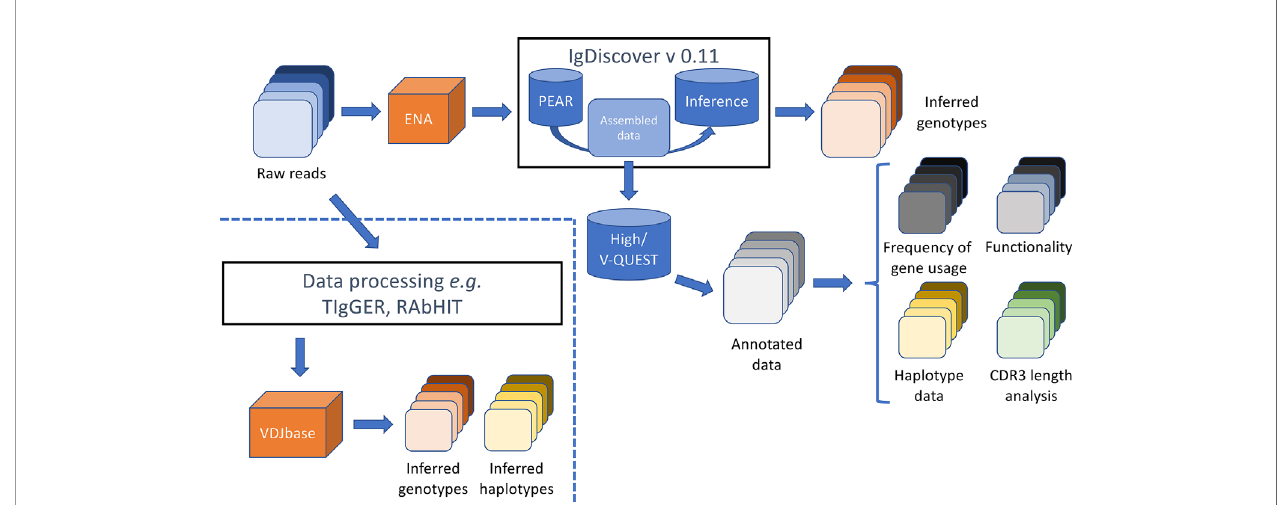
FIGURE 1 | Summary of analysis process and output fi les. Raw sequence data was obtained from the European Nucleotide Archive (ENA) and processed by IgDiscover to generate an inferred genotype of each subject. The assembled sequence fi les that were generated during the IgDiscover process were used to de fi ne (1) the closest germline gene, (2) the perceived functionality, (3) the association to alleles of IGHJ6 (for haplotype analysis), and (4) the length of the encoded CDR3, of each read as assessed by IMGT/HighV-QUEST. Output fi les generated after analysis by TIgGER (7, 10) and RAbHIT (18) (to de fi ne the IGHV genotype of investigated individuals, and haplotypes as de fi ned by association of reads to alleles of IGHJ6, respectively) were obtained directly from the VDJbase portal (https://